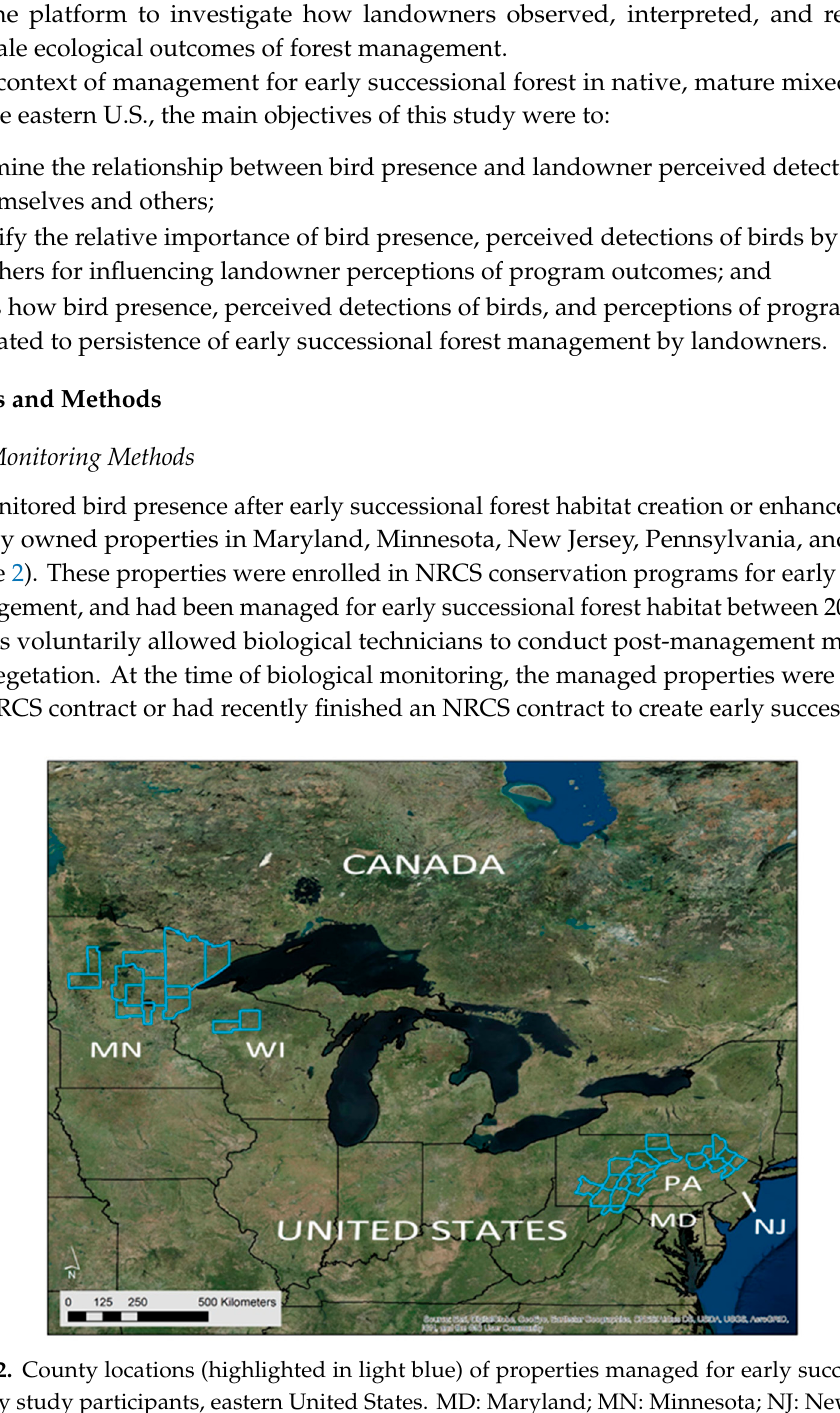
Figure 2. County locations (highlighted in light blue) of properties managed for early successional forest by study participants, eastern United States. MD: Maryland; MN: Minnesota; NJ: New Jersey; PA: Pennsylvania; WI: Wisconsin.